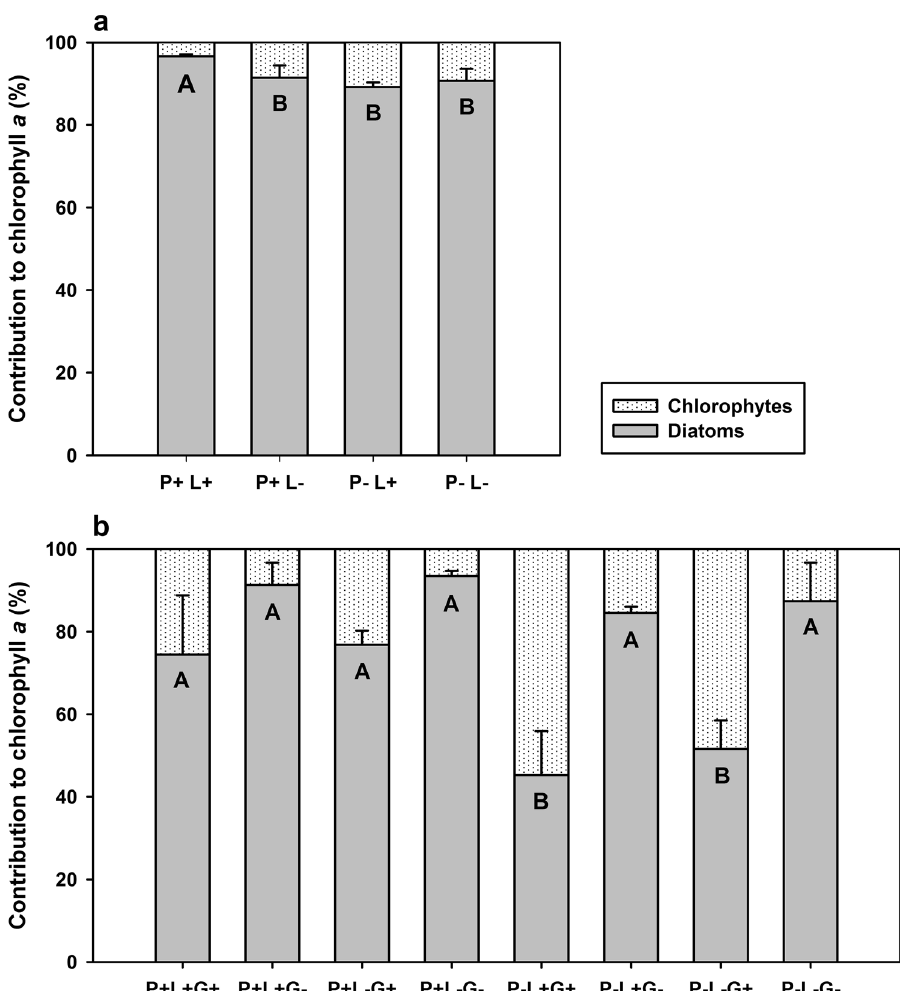
Figure 3. Interactive effects of phosphorus, light and grazing on periphyton taxonomic composition. Graphs depict periphyton relative abundance of diatoms and chlorophytes, measured as percentage contribution to total chlorophyll a at the beginning (10 June, a ) and end (7 August, b ) of the grazing phase at high phosphorus (P+) and low phosphorus supply (P−), high light (L+) and low light availability (L−) and in the presence and absence of grazers (G+ and G−, respectively). Values are mean ±SD of n = 6 ( a ) and n = 3 ( b ) replicate flumes. Diatom proportion was significantly increased by the interactive effects of P addition and light at the beginning of the grazing phase (two-way ANOVA; F 1,20 = 14.40, p < 0.001), whereas it was significantly decreased by the interactive effects of low P supply and grazing at the end of the grazing phase (three-way ANOVA; F 1,16 = 10.50, p = 0.005). Different letters in each panel indicate significant differences between treatments (Tukey’s HSD post- hoc test).